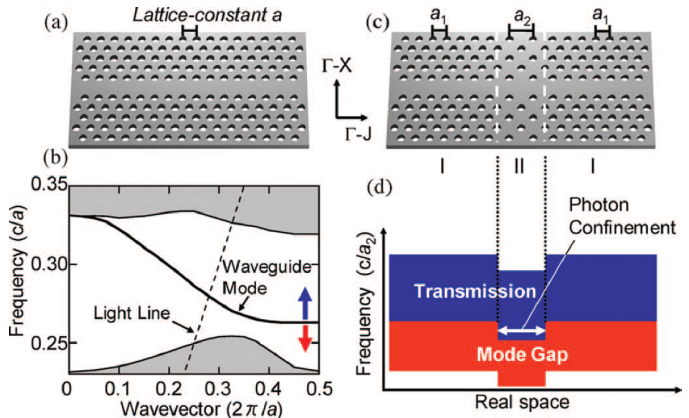
Figure 3. ( a ) Line-defect waveguide and ( b ) corresponding band structure. The blue (red) arrow in ( b ) denotes the pass-band (stop-band), where propagation of photons through the waveguide is allowed (inhibited). ( c ) Photonic heterostructure cavity. ( d ) Schematic representation of the band edges of the photonic heterostructure cavity along the waveguide direction. Reprinted from [12], with the permission of © IEEE,